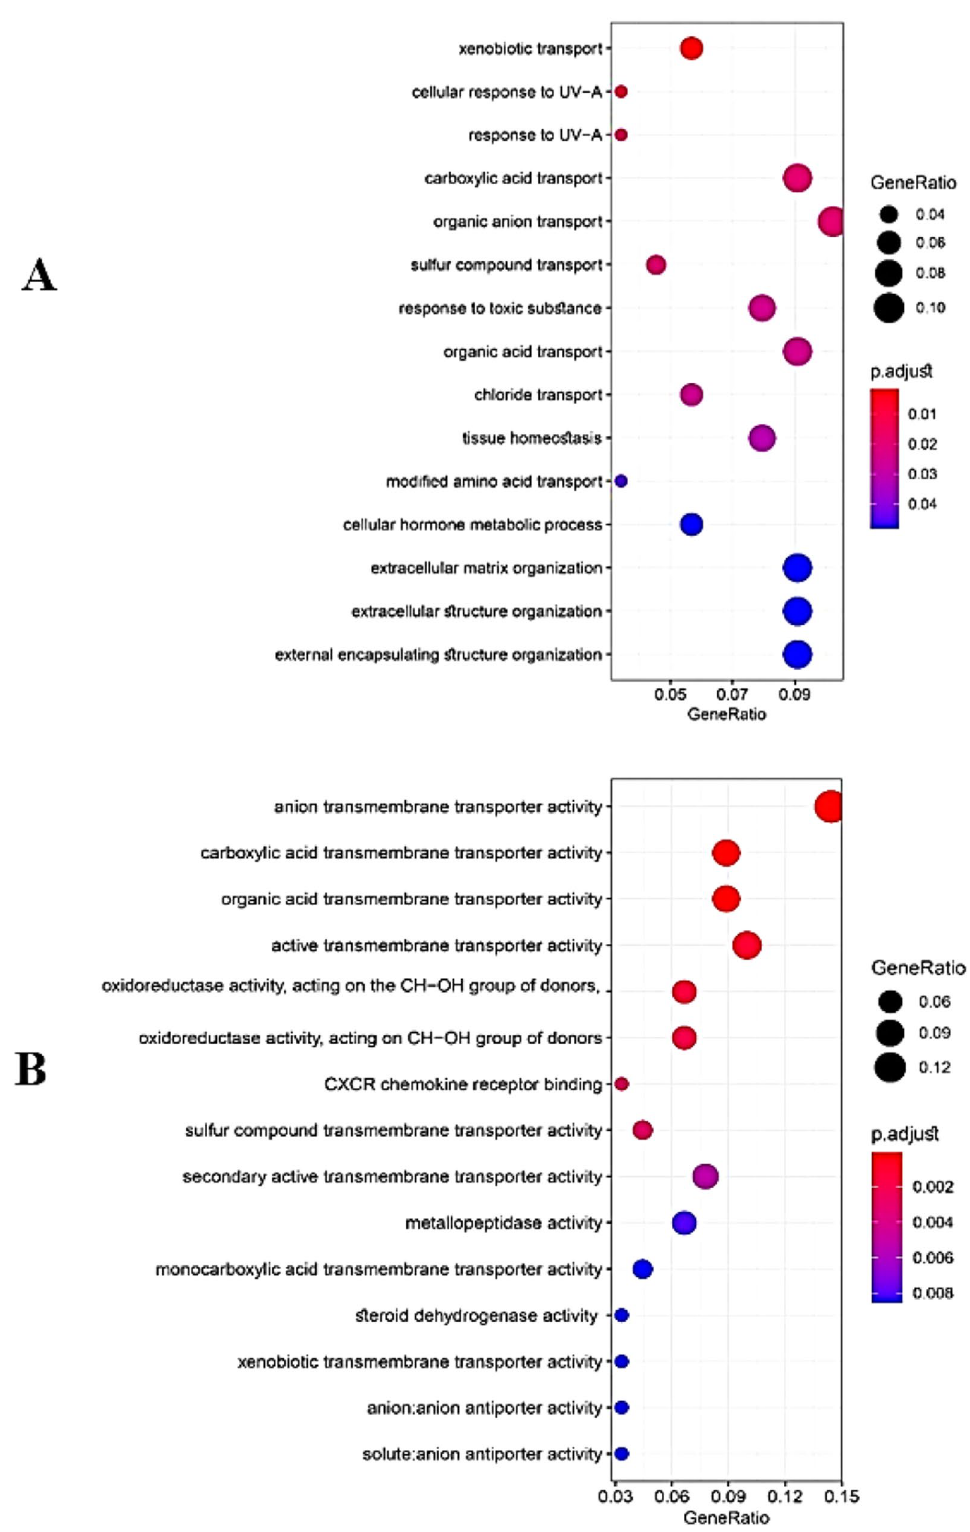
Figure 9. Bubble plot chart of Kyoto Encyclopedia of Genes and Genomes (KEGG) Enrichment path analysis of overlapping DEGs by ClusterProfiler and Rplot packages. The y-axis represents the KEGG-enriched terms. The x-axis represents the gene ratio. Dot size indicates the number of genes under a particular term. The color of the dots indicates the FDR value. ( A ) BP biology pathways ( B ) molecular